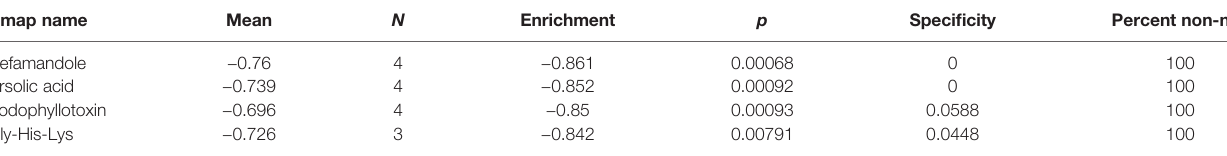
TABLE 4 | Ten hub genes were used to predict potential drugs for the treatment of